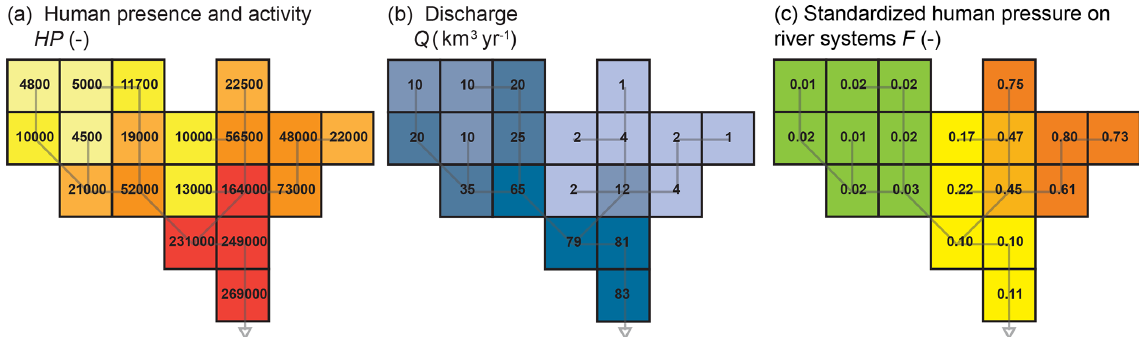
Figure 1. Estimation of human pressure on river systems by explicitly considering the topological nature of river basins. Schematic illus- tration of (a) cumulative human presence and activity, HP (–), calculated as routed nightlight values for each grid cell at 0.5 ◦ resolution, obtained from downstream propagation following flow direction paths (grey line; see Eq. 3), (b) natural river discharge, Q (km 3 yr − 1 ), ob- tained from downstream propagation following flow direction paths (grey line; see Eq. 1), (c) standardized human pressure on river systems, F(t) (–), for each grid cell (see Eqs. 2 and 4, where min (f k ) = 50km − 3 yr and max (f k ) = 30000km − 3